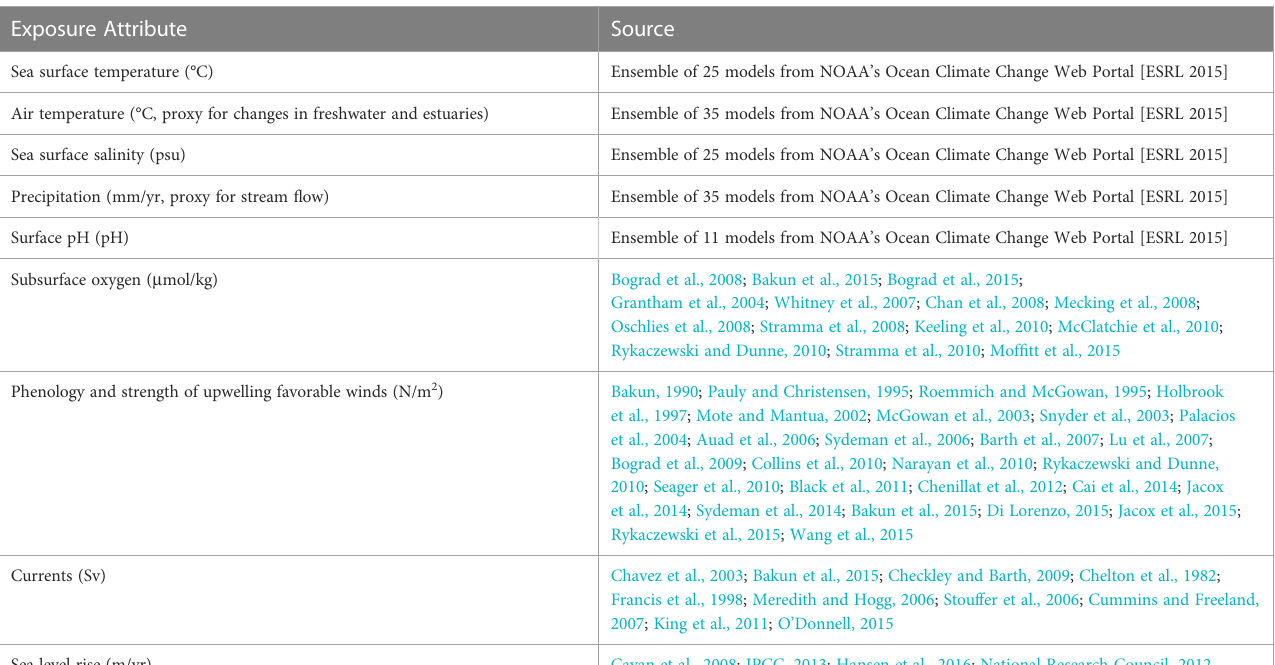
TABLE 3 Exposure factorss used in this climate vulnerability